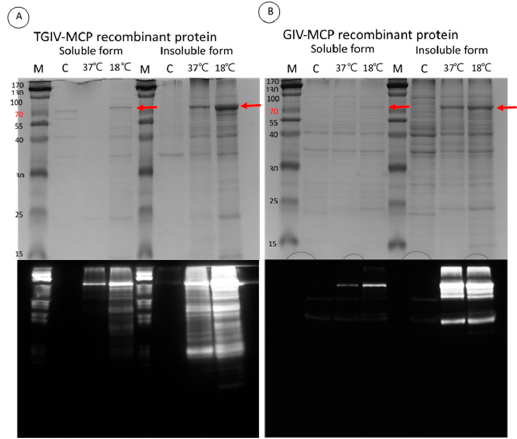
Figure 1. Induction of recombinant TGIV-MCP and GIV-MCP proteins at different temperatures. After addition of IPTG, the transformed E. coli cultures ( A : TGIV-MCP, B : GIV-MCP) were incubated at 18 or 37 °C for 12 h. Bacterial cells were harvested and homogenized. Both soluble and insoluble proteins were subjected to SDS-PAGE ( upper panels), followed by Western blotting with anti-His monoclonal antibody ( A ) or anti-GIV polyclonal antibody ( B ) ( lower panels). C: sample harvested prior to IPTG induction.